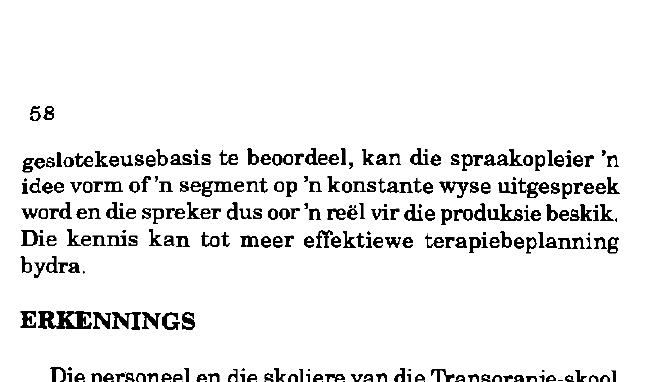
Die personeel en die skoliere van die TVansoranje-skool vir Dowes word vir hul vriendelike samewerking bedank. Erkenning word gegee aan die finansiele bystand van die Raad van Geesteswetenskaplike Navorsing. Opvat- tings en gevolgtrekkings wat gemaak word, is die van die skrywer en word nie noodwendig deur die Raad onderskryf